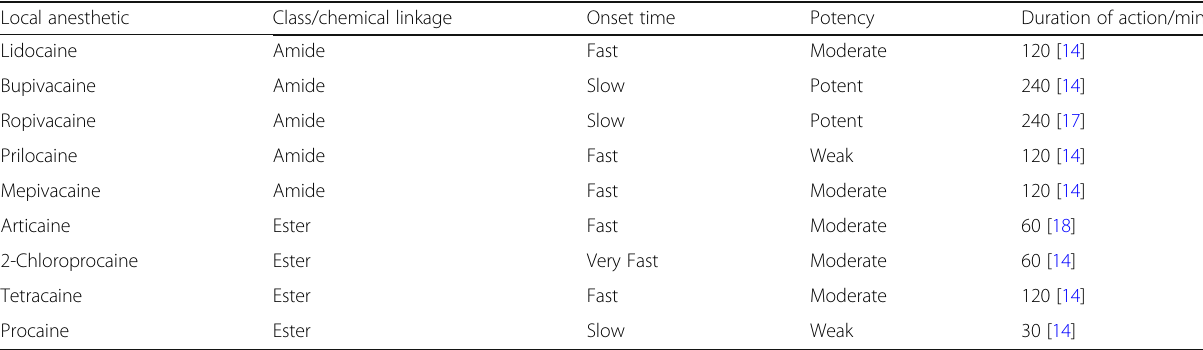
Table 1 Characteristics of LAs Local